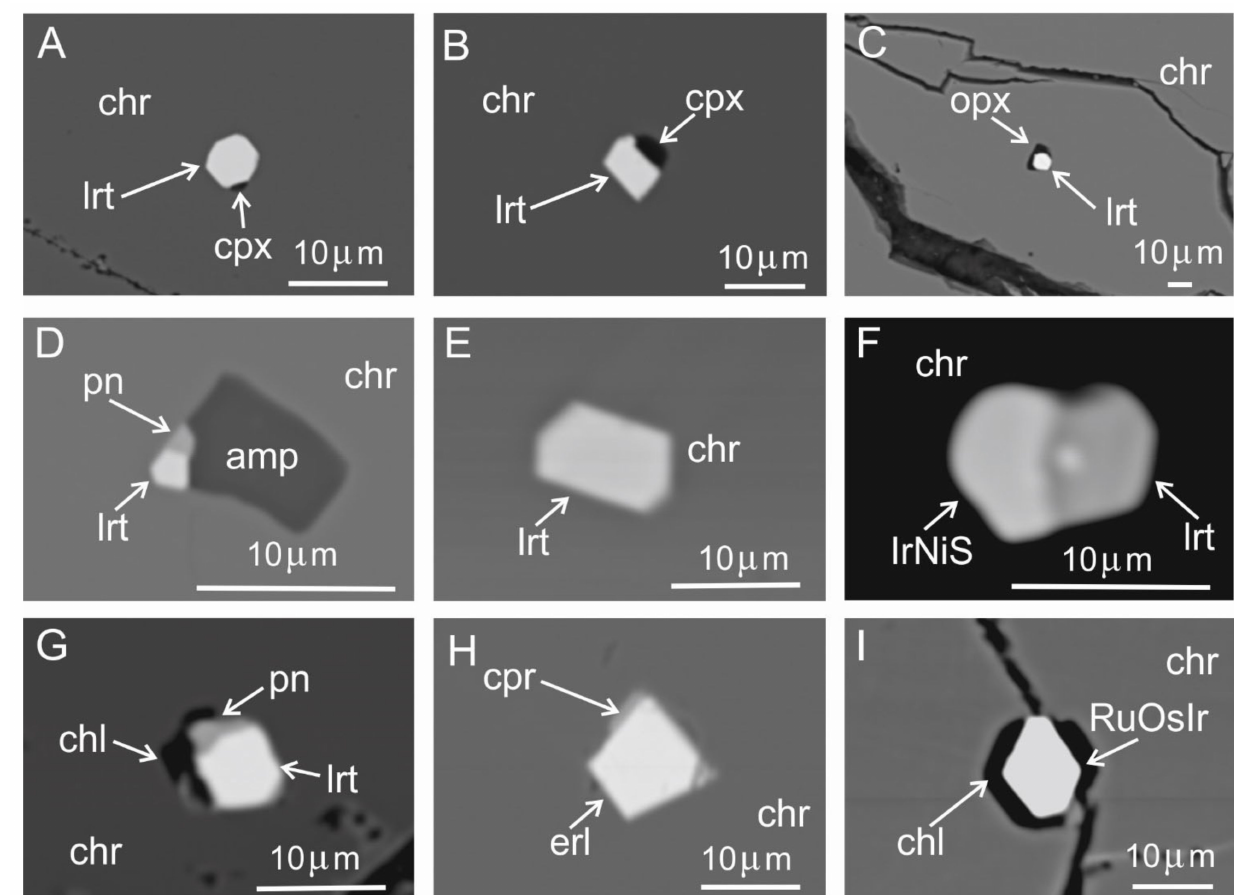
Figure 11. BSE images of primary PGM inclusions in chromite from the deposits of Kraka. Laurite + clinopyroxene, samples BB7617 ( A ), BB7671 ( B ); laurite + orthopyroxene, sample BB7618 ( C ); laurite + pentlandite + amphibole, sample BB7619 ( D ); laurite, sample PE1758 ( E ); laurite + Ir-Ni sulfide, sample PE1754a, ( F ); laurite + pentlandite + chlorite, sample PE1752 ( G ); erlichmanite + cuproiridsite, sample PE1757a ( H ); Ru-Os-Ir alloy + clinopyroxene + chlorite, sample PE1757b ( I ). Abbreviations: chr = chromite; cpx = clinopyroxene; opx = orthopyroxene; amp = amphibole; lrt = laurite; cpr = cuproiridsite; IrNiS = unnamed Ir-Ni sulfide; pn = pentlandite; erl = erlichmanite. Sample BB = Bolshoi Bashart; sample PE = Prospect